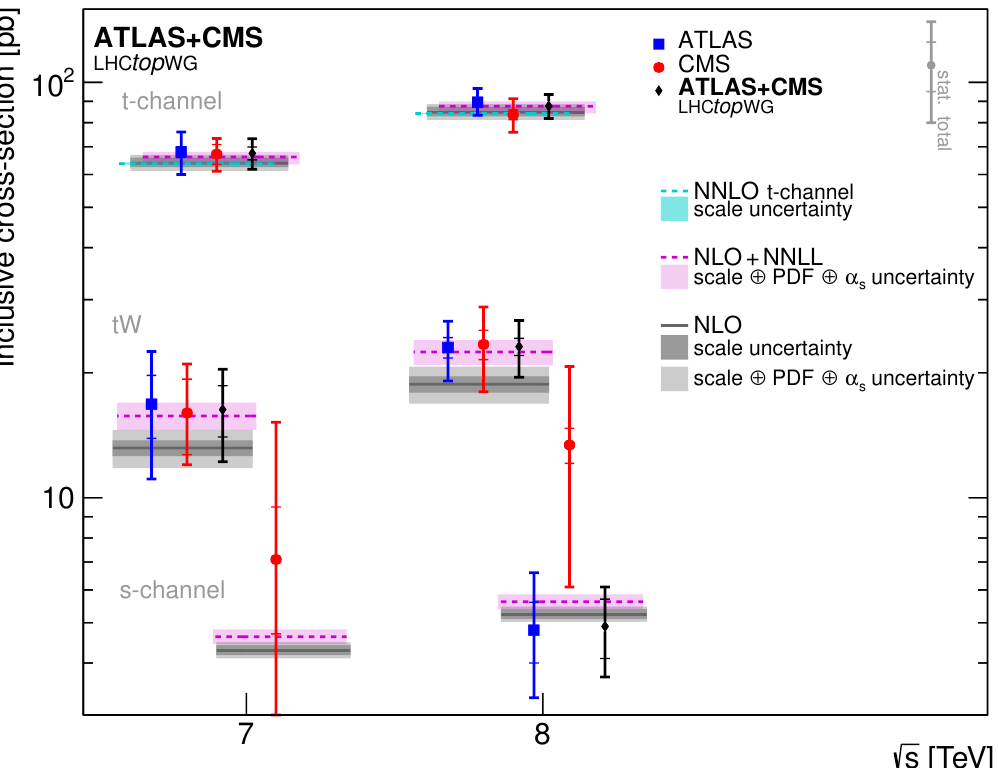
Figure 2 . Single-top-quark cross-section measurements performed by ATLAS and CMS, together with the combined results shown in sections 6.1{6.3. These measurements are compared with the theoretical predictions at NLO and NLO+NNLL for all three production modes and the prediction at NNLO for t -channel only. The corresponding theoretical uncertainties are also presented. The scale uncertainty for the NNLO prediction is small and is presented as a narrow band under the dashed